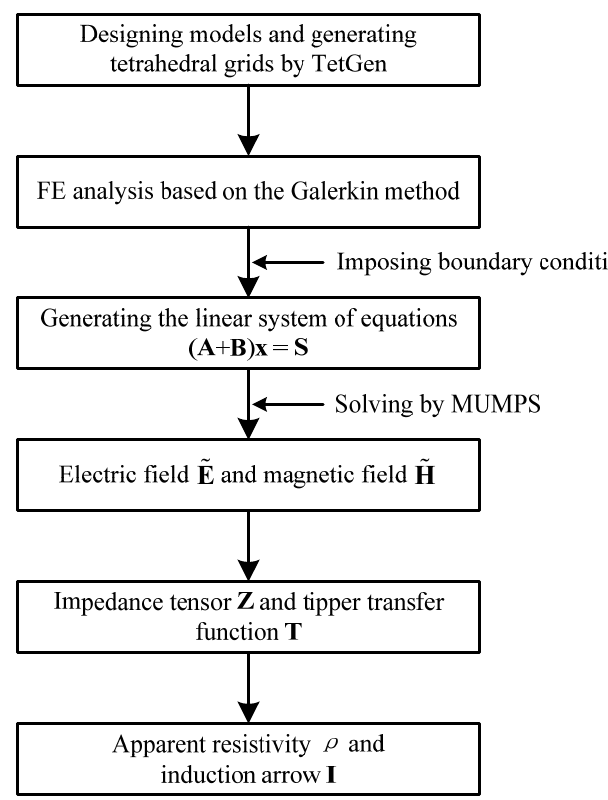
Figure 1. A flowchart of the FE method used in this study for calculating MT responses.